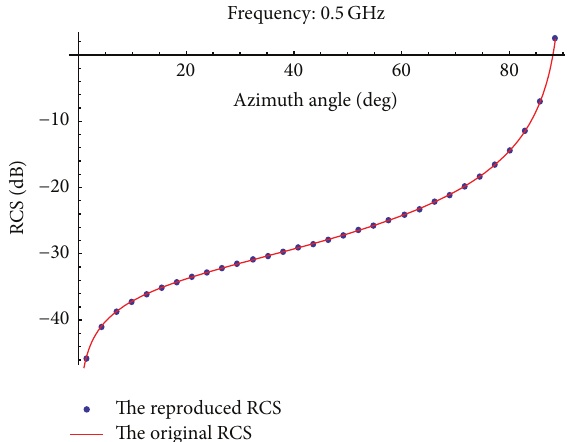
Figure 1: Elliptical cylinder.